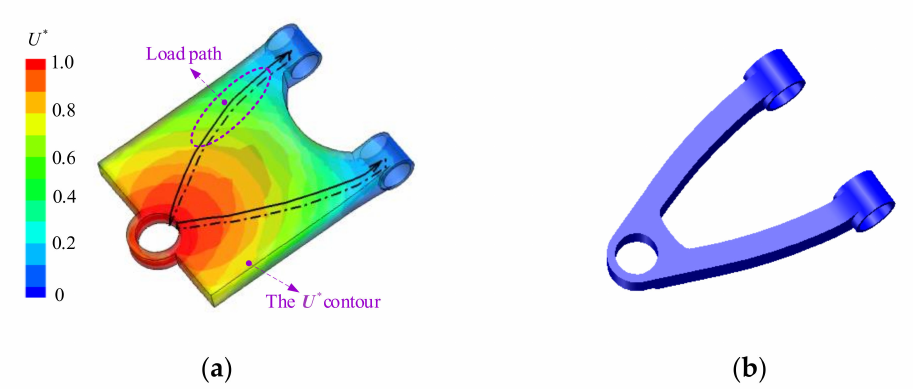
Figure 10. The main-branch of the control arm: ( a ) load path visualization; ( b ) two